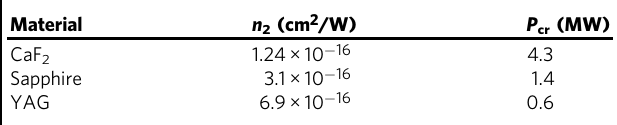
Fig. 8a, respectively. The thicknesses of these plates are all 3 mm. We adjusted the input pulse energy for each plate to be as high as possible using a variable attenuator and an aperture under the upper limit energy to reveal a rapid oscillating structure on the white-light spectrum, which was known as a result of the refocusing of the fi lament 34 , in the relevant wavelength range of the SWIR (from approximately 1 – 2.4 μ m). The resultant pulse energies were 2.9 μ J for the CaF 2 plate, 1.3 μ J for the sapphire plate, and 0.65 μ J for the YAG plate. We found that the intensity of the white-light spectrum generated from the CaF 2 plate was the highest in this fi gure. The wavelength of the spectrum was extended to 2.4 μ m. This result is due to the highest available input pulse energy and the lowest dispersion for the CaF 2 plate. As for the dispersion, the difference between the maximum and minimum group delays for the SWIR region in the CaF 2 plate was evaluated to be less than 40 fs, shown as a blue solid curve in Fig. 8b, which is only less than 30% of that in the sapphire and YAG plates, shown as a green dotted and a brown dash-dot curve in Fig. 8b, respectively. The group delay of less than 40 fs ensured the temporal overlap of the pump pulse with a duration of 60fs, shown as a shaded area in Fig. 8b, to the whole spectrum in the SWIR region. Therefore, we adopted the CaF 2 plate for the WLG in the OPA system. The highest pulse energy of the input pulse to the CaF 2 plate comes at the cost of the need to compensate for the lowest nonlinear refractive index, and thus, it leads degradation of the plate in a long term use. We observed the instability of the